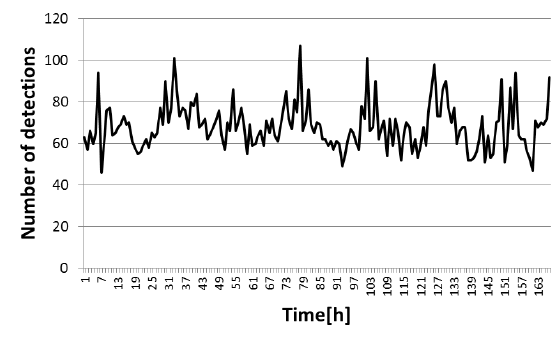
Figure 10: Number of detections for signature num- ber 8.